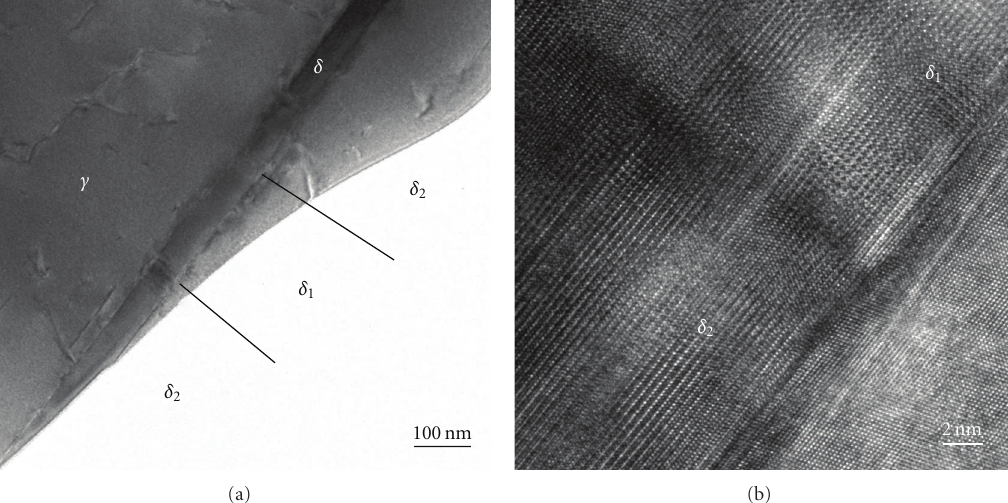
Figure 9: TEM observation of a δ platelet in a 718 alloy sample aged 3h at 960 ◦ C. The low-magnification bright field image in (a) shows the extent of di ff erent variants of the δ phase, detailed in the HRTEM image of the same sample in